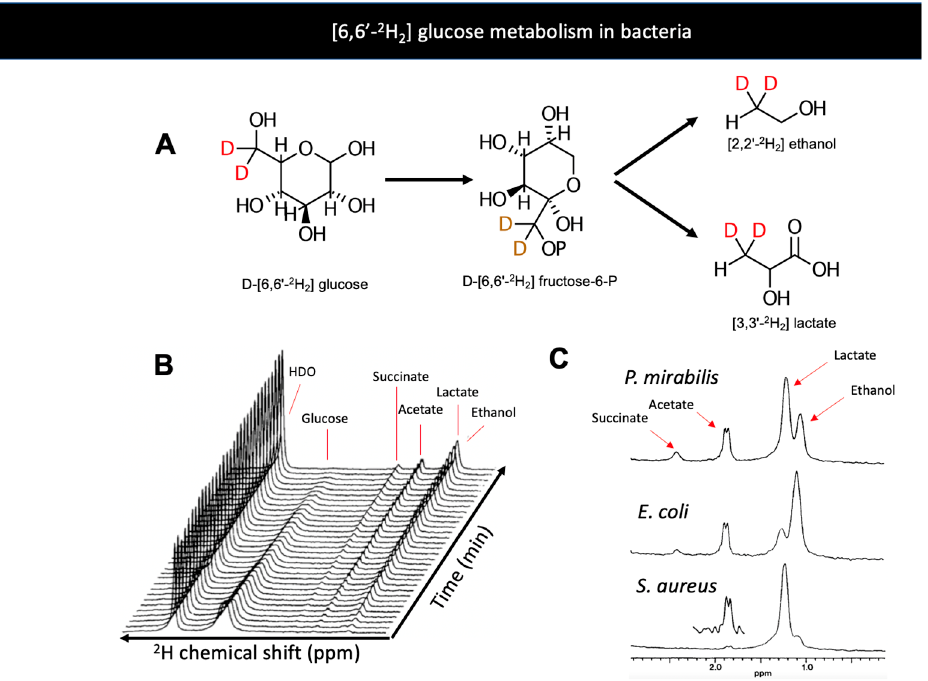
Figure 3. ( A ) Bacterial metabolism of D ‐ [6,6 ′‐ 2 H 2 ] glucose produces the metabolites D ‐ [6,6 ′‐ 2 H 2 ] lac ‐ tate and D ‐ [6,6 ′‐ 2 H 2 ] ethanol. ( B ) Dynamic conversion of D ‐ [6,6 ′‐ 2 H 2 ] glucose to metabolic products studied in vitro by 2 H NMR (Aguayo et al. 1988). The majority of 2 H signals are incorporated into lactate and ethanol over time (just downfield of 1 ppm). ( C ) 2 H spectra of products of glycolysis by E. coli , P. mirabilis , and S. aureus , three significant pathogens in humans. Adapted from Aguayo et al. 2021 (Creative Commons Attribution License, CC